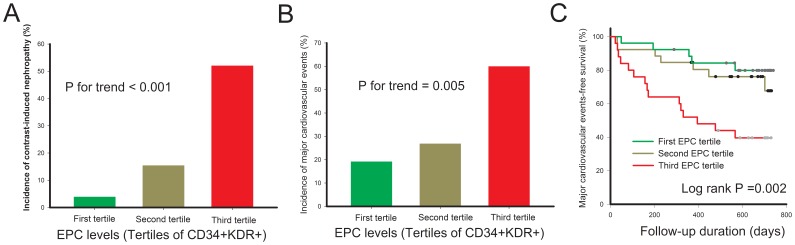
Association between tertiles of EPC level, and incidence of contrast-induced nephropathy (A), major cardiovascular events (MACE) (B), and MACE-free survival (C).First tertile: EPC (CD34+KDR+ ≧9 cells/105 events); Second tertile: EPC (CD34+KDR+ = 5–8 cells/105 events); Third tertile: EPC (CD34+KDR+ ≦ 4 cells/105 events).